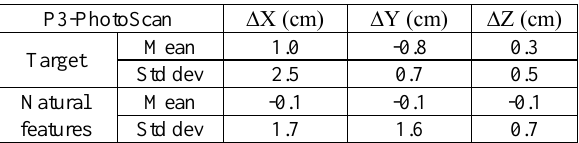
Table 6. Mean and standard deviation of CPs for model P3-PS (SCS).